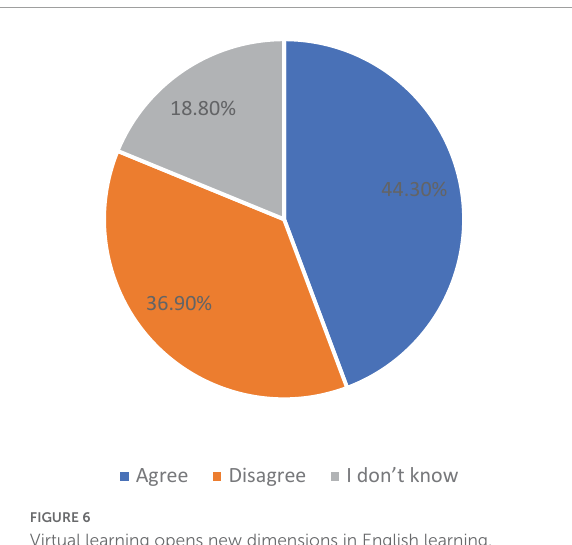
learning English. In contrast, 30.2% of the students did not agree with the benefit of virtual learning related to increasing students’ self-dependency in learning English. Finally, 18.8% of them did not show any opinion. They did not know whether virtual learning increased or not their self-dependency in